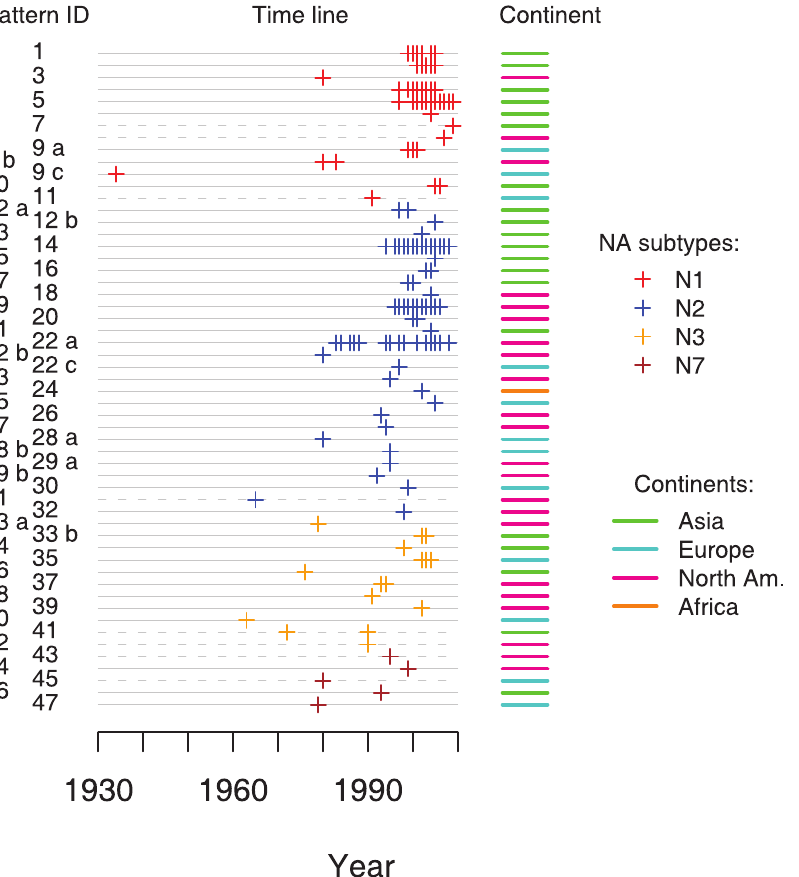
Figure 3. Spatial-temporal distribution of S D NA patterns. Each line indicates an instance at which an S D NA pattern emerged (refer to Methods for definition). Pattern IDs on the left are the same as in Figure 1. Deletion patterns that are distributed over several distinct clades are indicated by lower case letters. Each cross indicates a year at which a particular pattern was observed. Crosses are color-coded for NA subtype. Bars on the right indicate the continent in which the deletion pattern was most commonly observed. Dotted time lines indicate deletion patterns that are not shown in the phylogenetic trees because their NA genes were partially sequenced. The results of our analysis that controlled for phylogenetic dependent transition rates between full-length-NA and S D NA. dependence due to shared NA ancestry suggest that the positive Previous studies have indicated that naturally-occurring S D NA correlation between S D NA and gallinaceous hosts is caused by host- mutants tend to appear in gallinaceous hosts but did not Table 2. Bayesian estimation of joint transitions between gallinaceous and non-gallinaceous hosts and full-length-NA and S D NA.